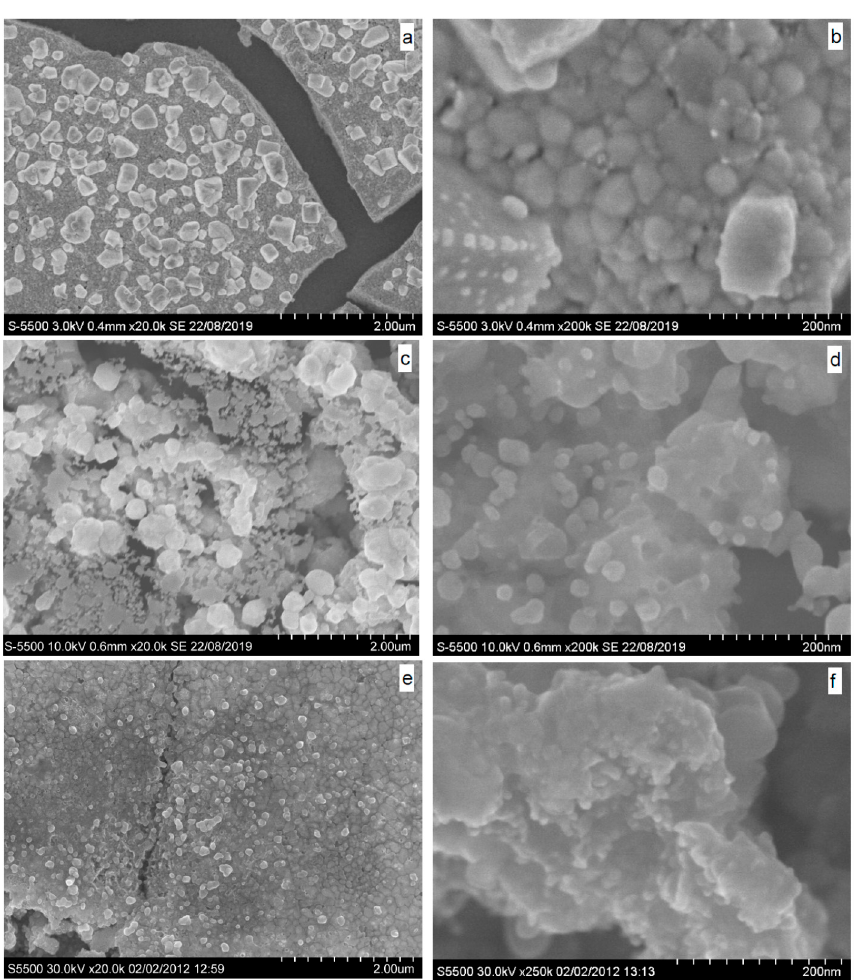
Figure 4. SEM images of silver films conditioned in ( a , b ) 0.2 mM HAuCl 4 solution for 30 min and 4 mM HAuCl 4 solution for 12 min ( c , d ) and 60 min ( e , f ).